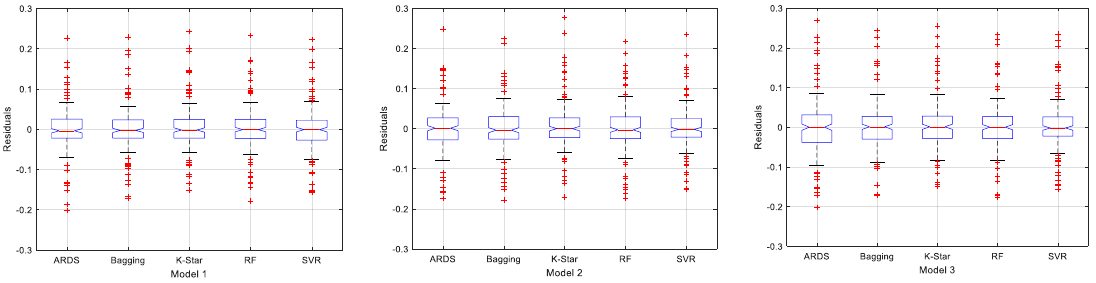
Figure 11. Aspect ratio prediction: box plots of the residuals.